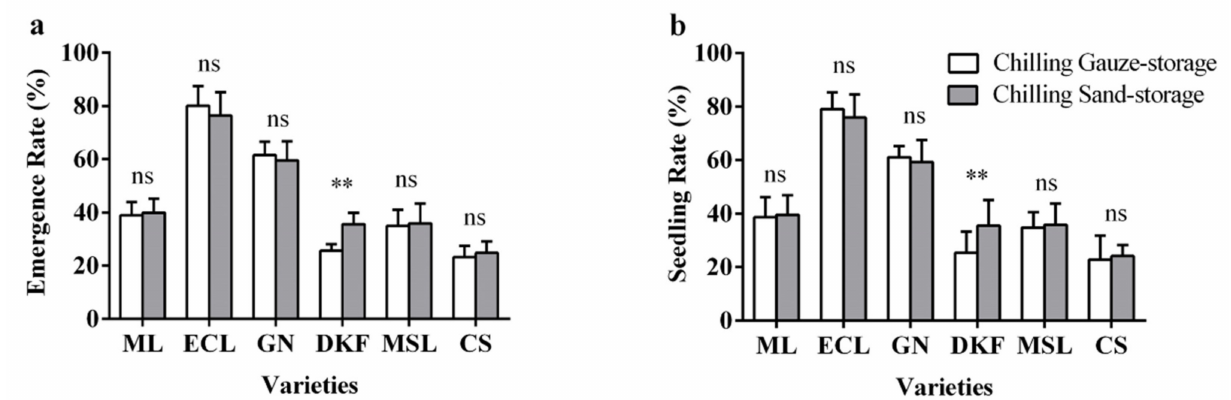
Figure 5. Effect of stratification treatments on seed seedling characteristics of six tested varieties: ( a ) influence of stratification treatments on seed seedling rate of tested varieties, and ( b ) influence of stratification treatments on seed seedling rate of tested varieties. Data in this figure were tested by Student’s t test; ** p < 0.01 represent significant differences between treatments, and ns indicates not significant. ML, ECL, GN, DKF, MSL, and CS represent varieties of Meili, Ecolly, Garanior, Dunkelfelder, Marselan, and Cabernet Sauvignon.